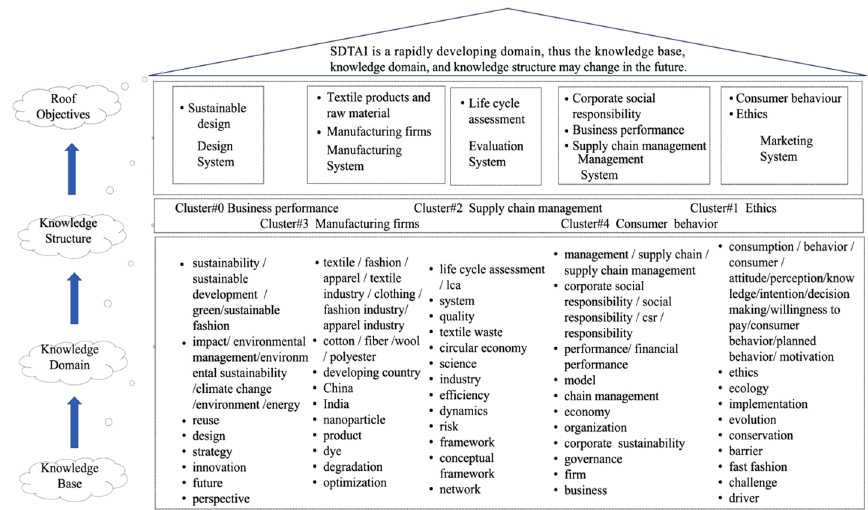
Fig. 4 Knowledge roadmap for the sustainable development of the textile and apparel industry